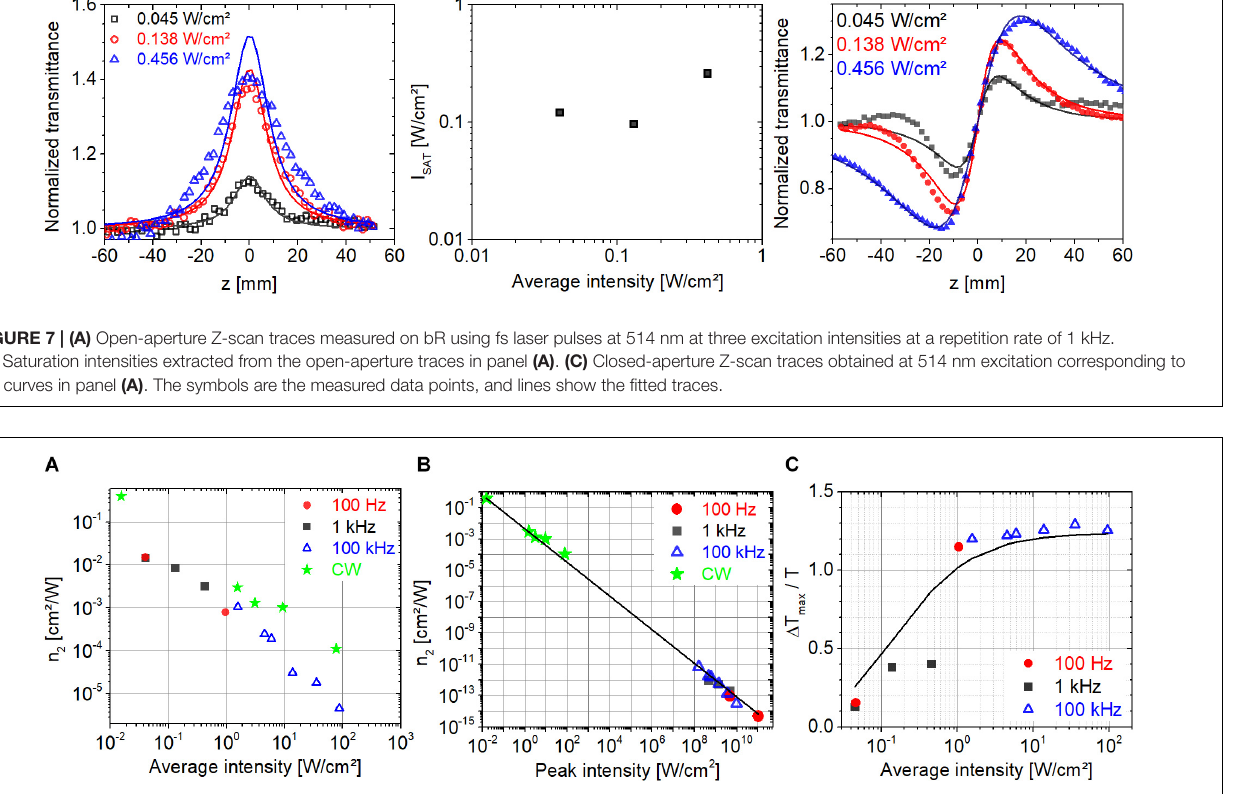
FIGURE 8 | Nonlinear refractive index of bR at 514 nm as a function of (A) average and (B) peak intensity. (C) The relative change in transmission as a function of average intensity. The solid line is a fit of a saturable absorption model on all measured